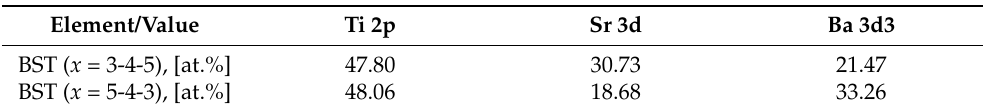
Table 8. Atomic concentration table according to the results of the XPS spectrum measurement